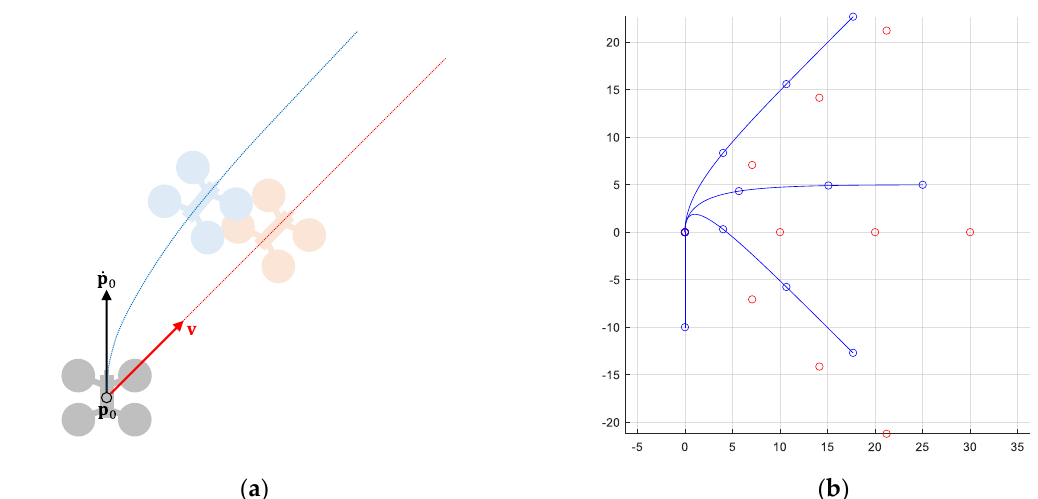
Figure 1. UAV dynamic model. ( a ) Example of a UAV turning 45° clockwise: the red line shows the ideal trajectory followed if the commanded velocity is applied instantaneously ( |𝐩̇ 𝟎 | = |𝐯| = 10 𝑚/𝑠 ); the blue line shows its dynamic trajectory assuming 𝜏 = 0.5 𝑠 . ( b ) Ideal and real position (every second) of the UAV when turning 45°, 90°, and 135°, respectively.